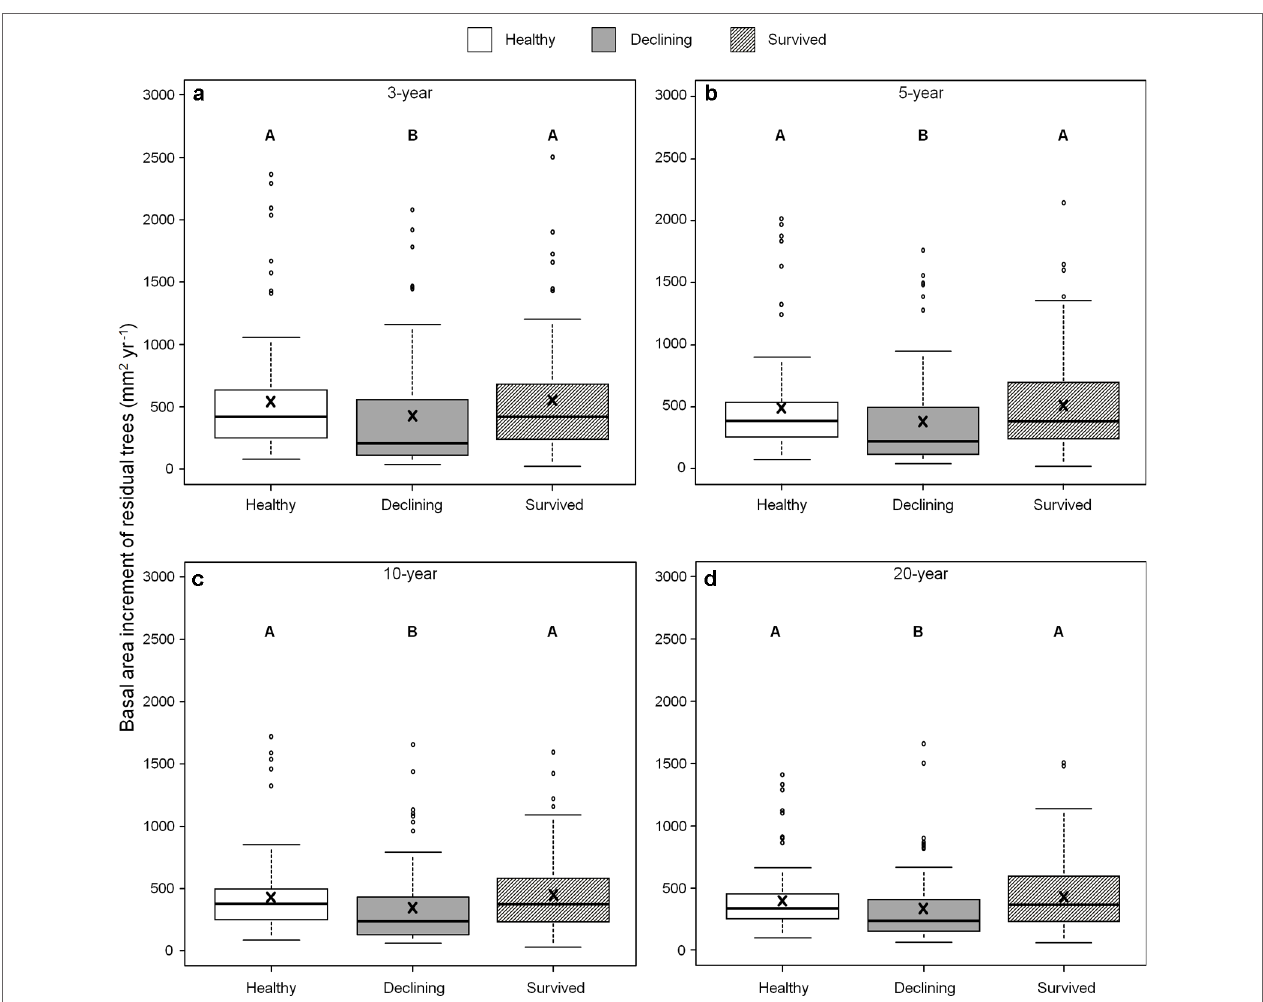
FIgURe 5 | Basal area increments of three categories (healthy, declining, survived) of residual Pinus contorta var. latifolia trees in the four most recent growth periods (3 (a) , 5 (b) , 10 (c) , and 20 years (d) ). Significant differences among three tree categories were indicated by different letters based on the results of linear mixed-effects models (α = 0.05). In each box plot, the thick line is the median, × mark indicates the mean, the box represents the 1st and 3rd quartiles, whiskers are Tukey’s 1.5 interquartile range, and the open circles indicate outliers. Basal area increment was log-transformed to stabilize the normality and homogeneity of variance of model